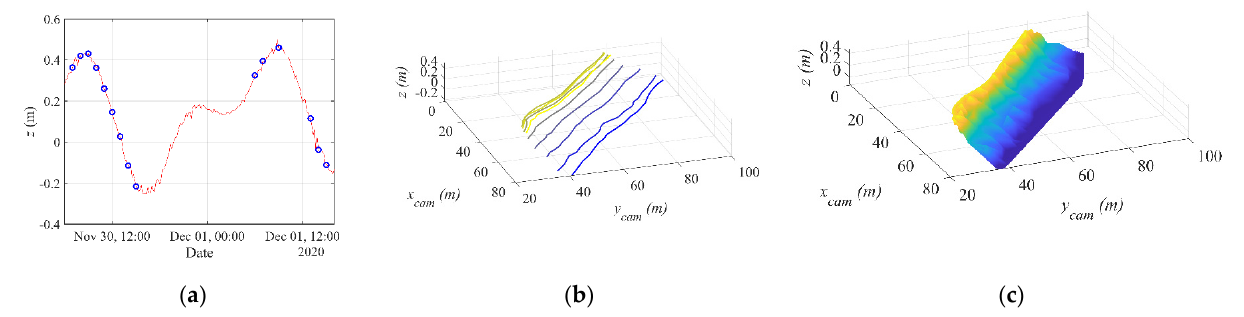
Figure 2. Example of intertidal bathymetry reconstruction by the VISTAE camera: ( a ) Tidal level from tide gauge measurements (blue circles). ( b ) Shoreline detected at the same time as the tidal level measurements. ( c ) Intertidal bathymetry interpolated from the detected shorelines.